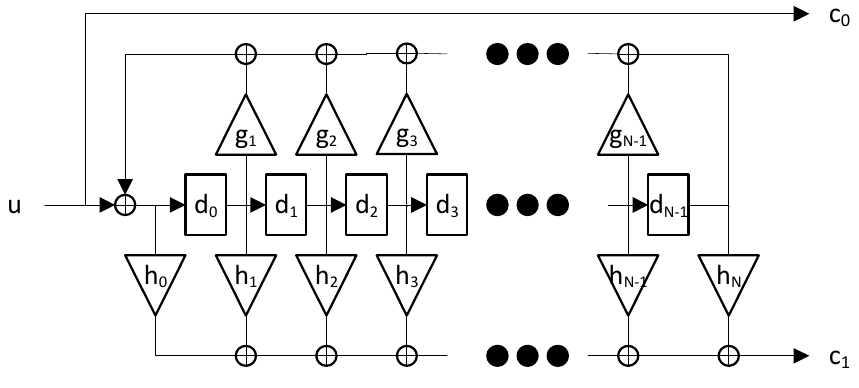
Figure 1. Architecture of a recursive systematic convolutional (RSC) encoder with R = 1